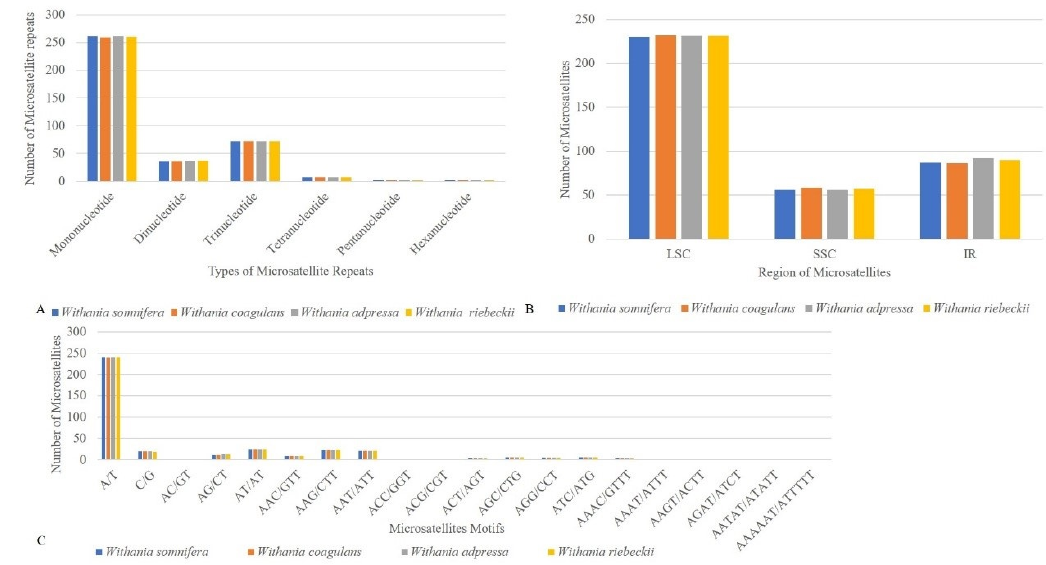
Figure 5. Comparative analysis of microsatellite repeats among Withania species. ( A ) Total number of microsatellites and their classification according to the number of repeat units. ( B ) The distribution of microsatellites among structural regions of the plastome. ( C ) Repeat unit composition of Withania microsatellites.